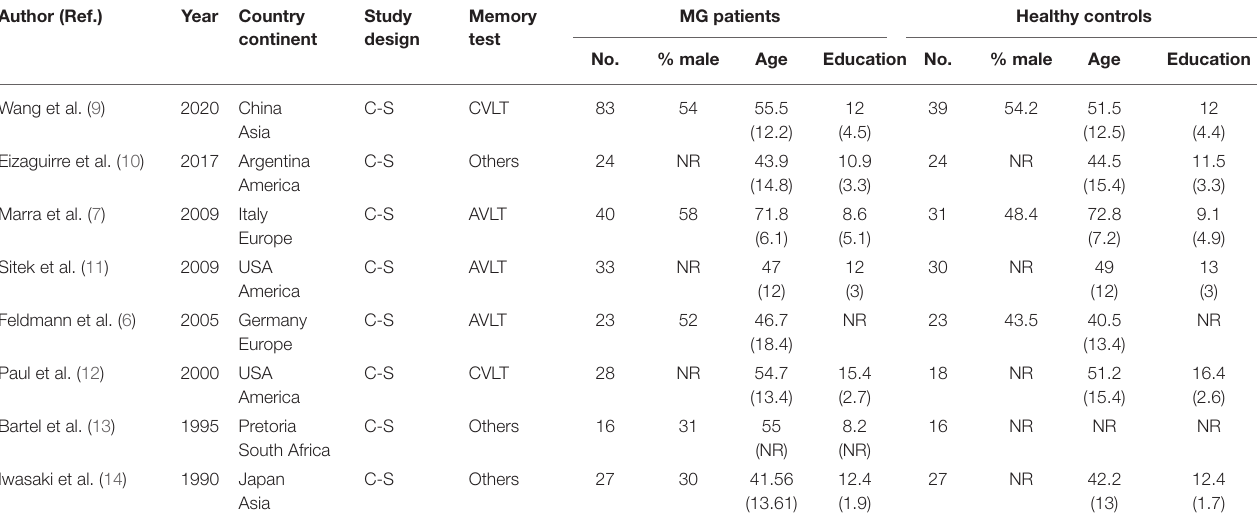
TABLE 1 | The characteristics of the studies included in the meta-analysis. Author